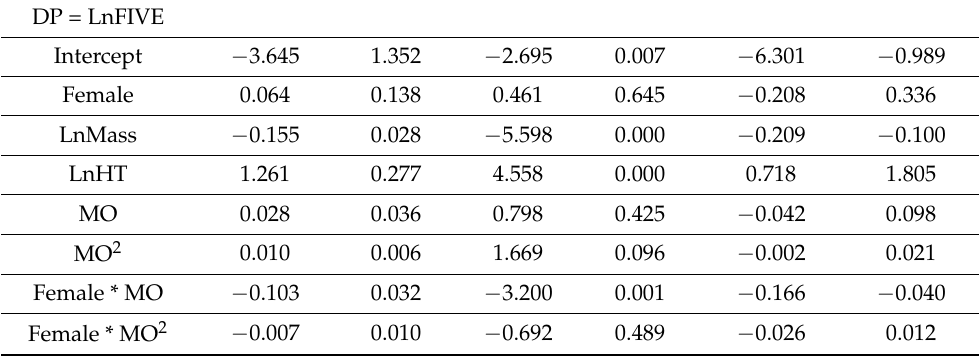
Lower Upper Bound